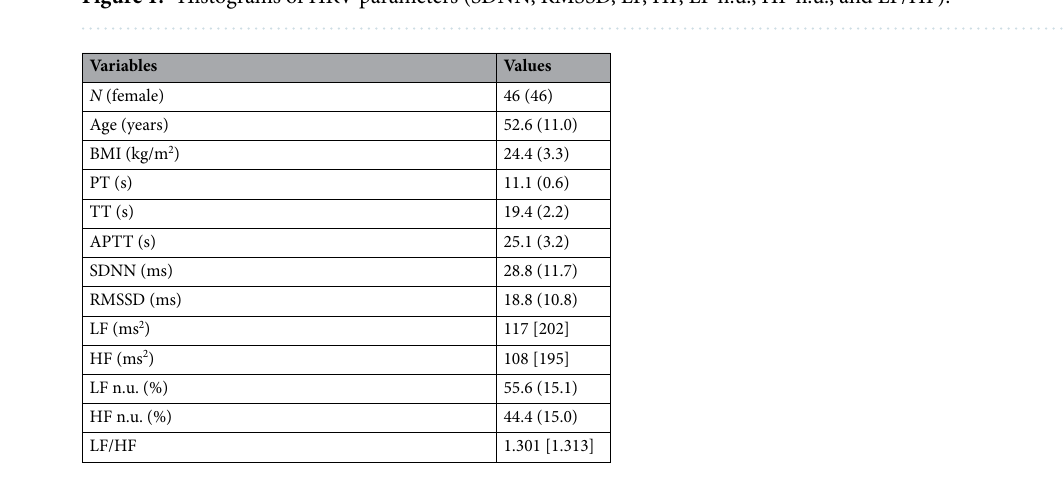
Table 1. Basic data of the studied BC patients. Values are expressed as the mean (SD) or median [interquartile range]. BMI body mass index, PT prothrombin time, TT thrombin time, APTT activated partial thromboplastin time, SDNN standard deviation of normal-to-normal intervals, RMSSD the root mean square of successive heartbeat interval differences, LF low-frequency power, HF high-frequency power, LF n.u. low- frequency power in normalized units, HF n.u. high-frequency power in normalized units, LF/HF the ratio of low-frequency power to high-frequency power.